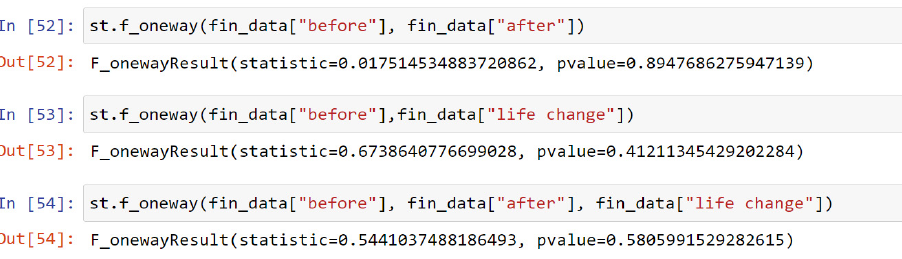
Figure A8. Levene’s test calculation via Jupyter Notebook and statistical functions (scipy.stats). Source: own research.